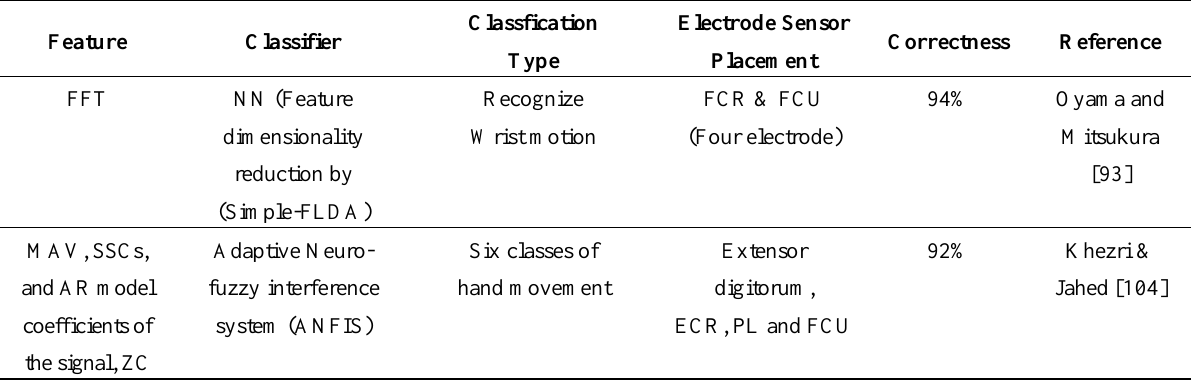
Table 9. Summary of different EMG classification